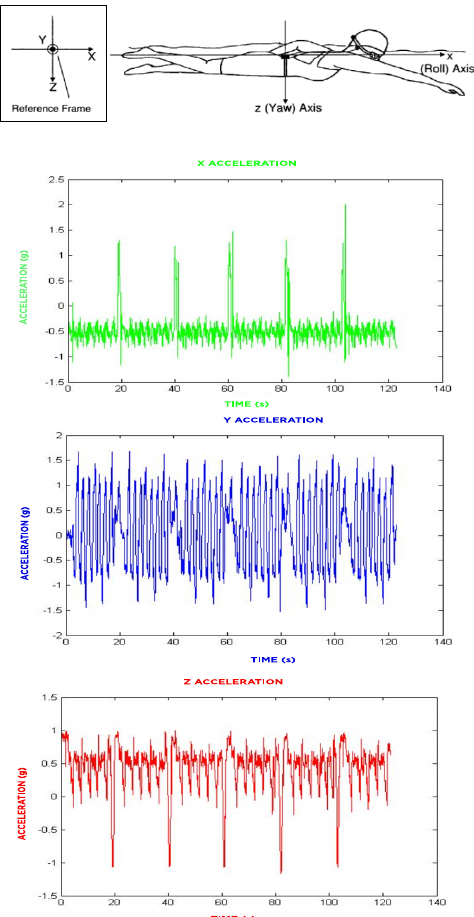
Figure 2: Reference tern and 3-axis accelerometer